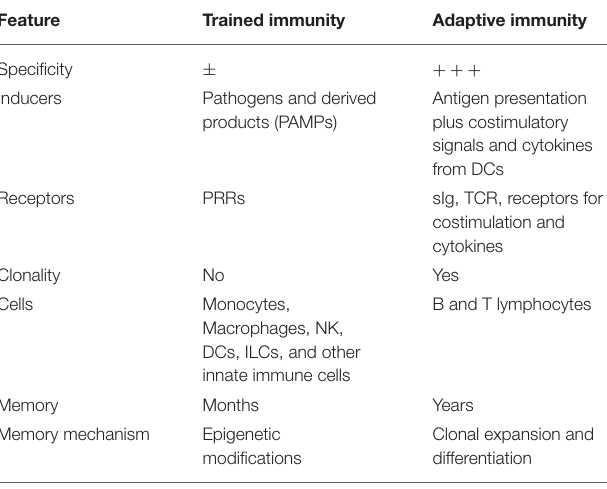
TABLE 1 | Similarities and differences between trained and adaptive immunity.